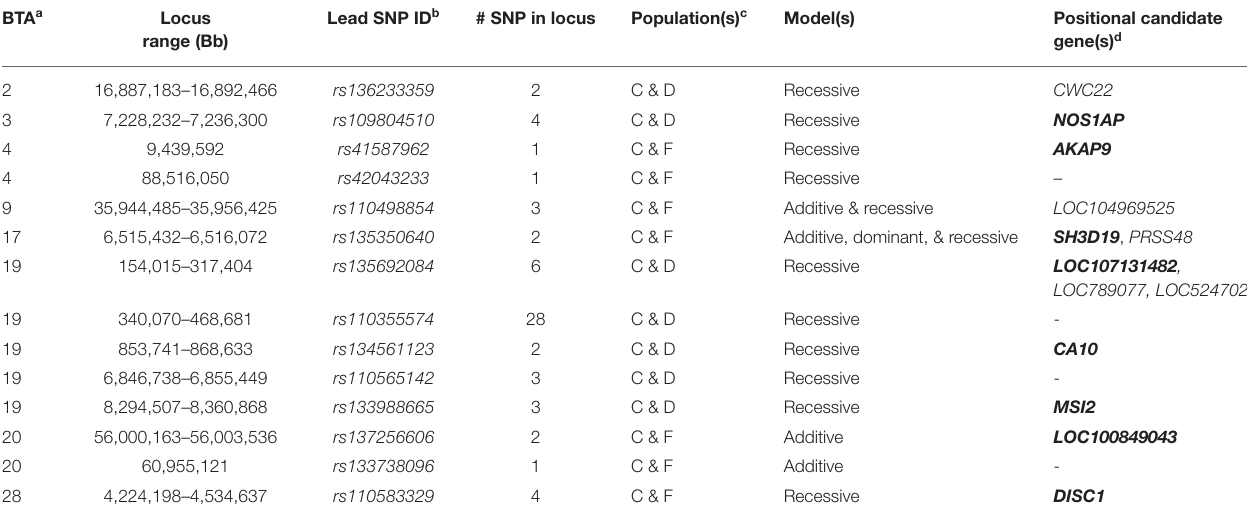
TABLE 2 | Loci associated with bovine coronavirus and bovine respiratory disease infections across populations. BTA a Locus Lead SNP ID b # SNP in range (Bb)